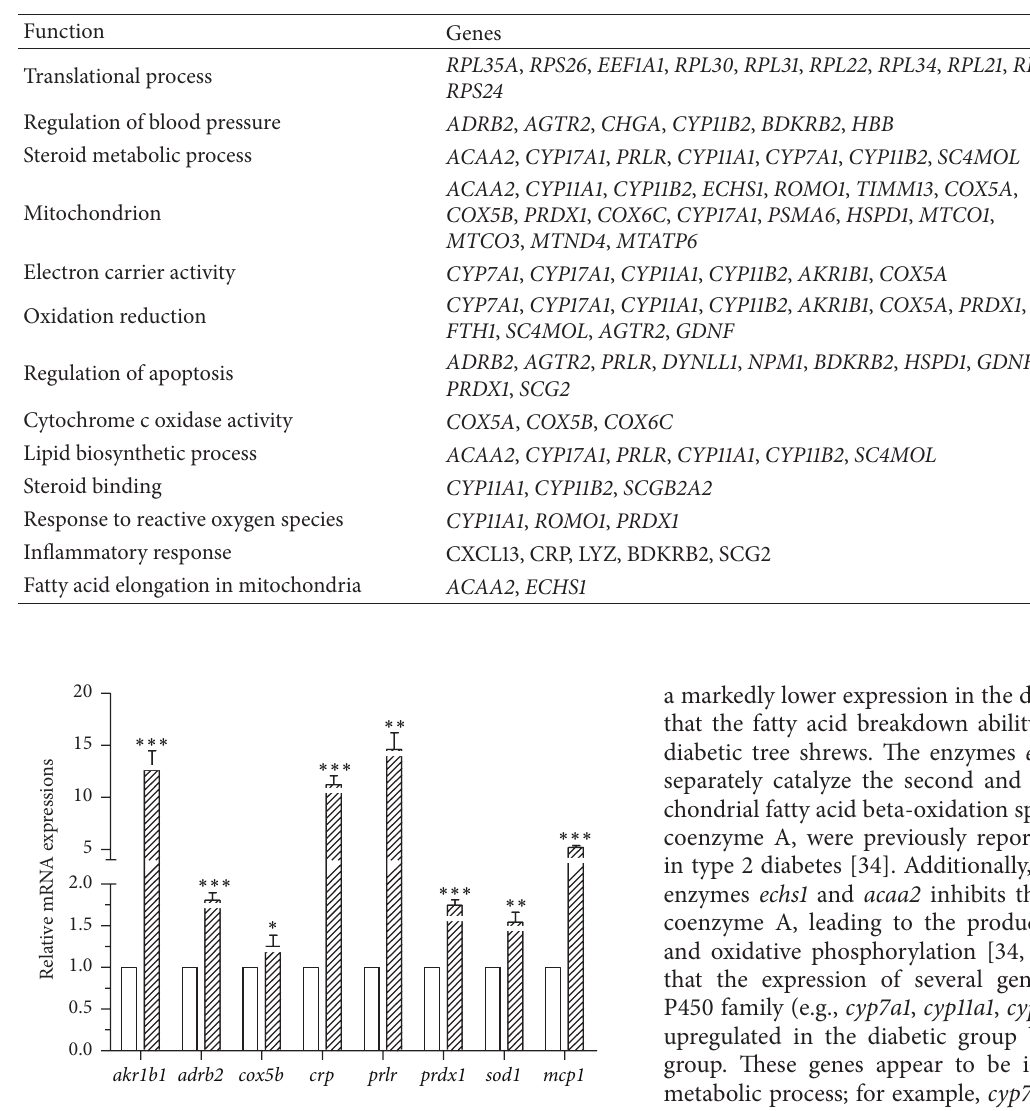
Table 3: Biological processes and genes likely affected among tree shrews with STZ-induced diabetes.